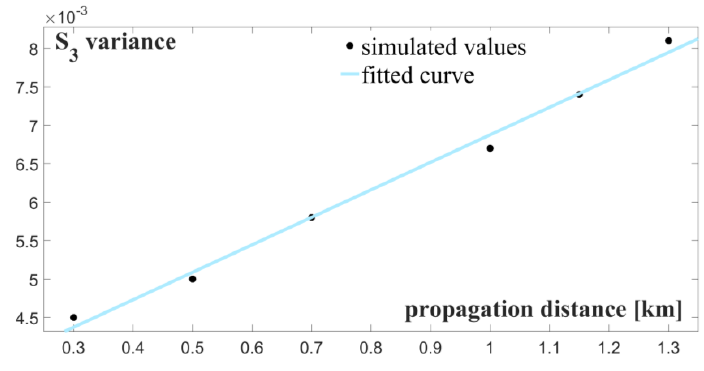
Figure 5. S 3 variance versus the propagation distance.